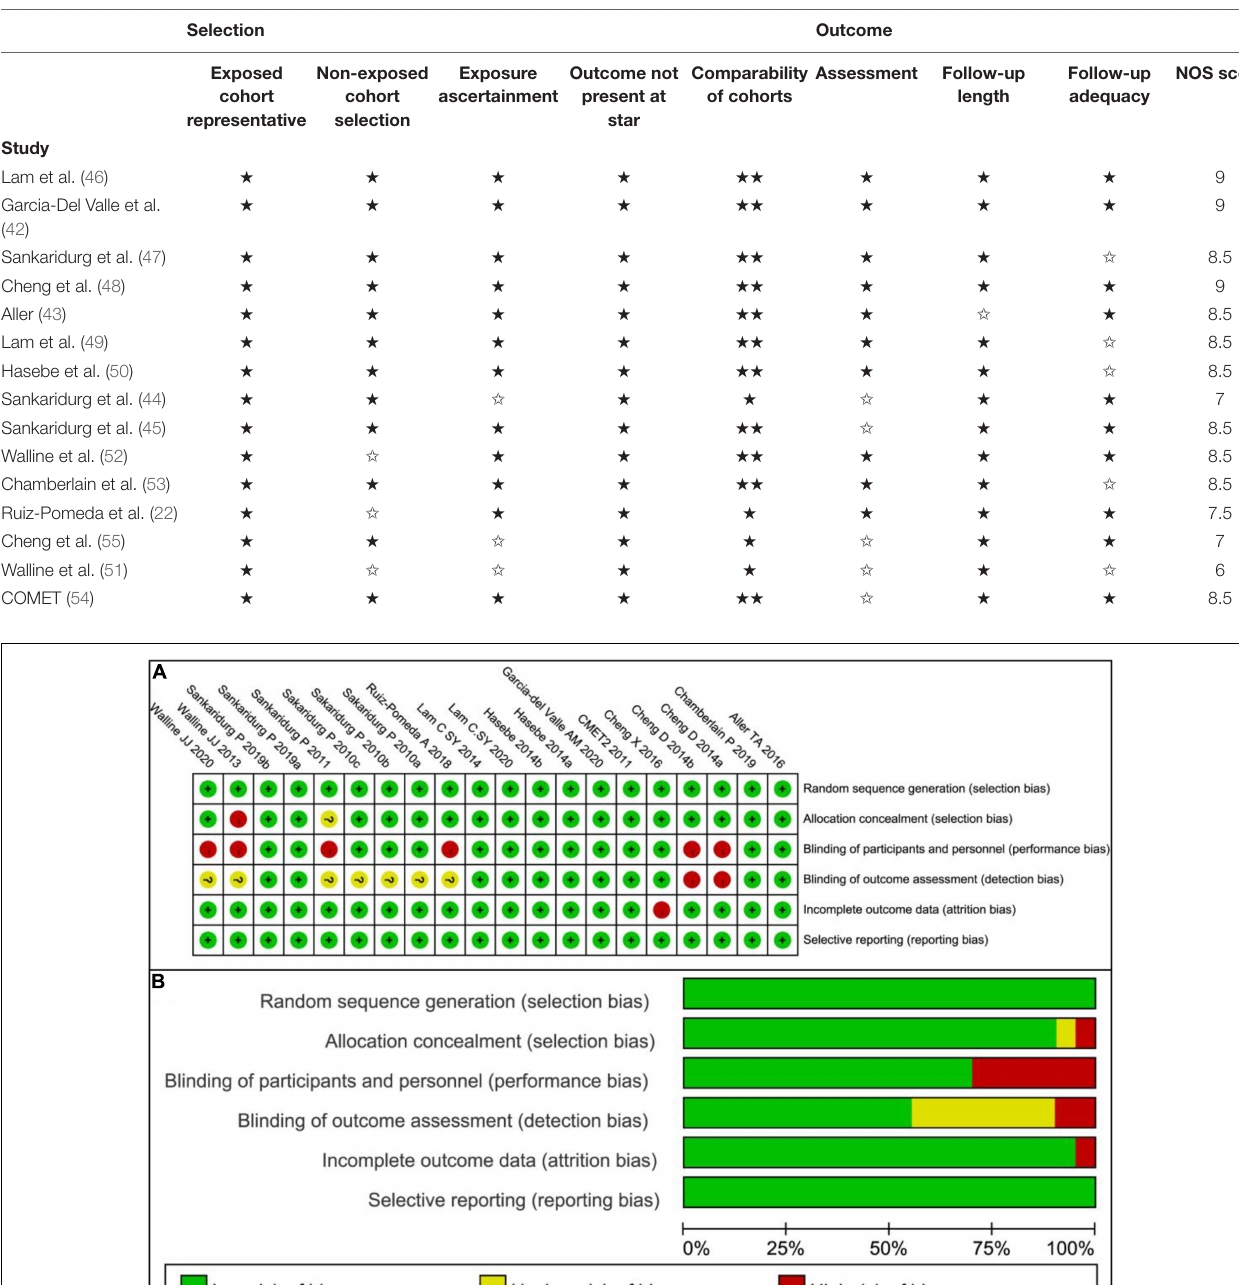
TABLE 3 | Quality assessment of cohort studies included in the meta-analysis using Newcastle–Ottawa quality assessment scale.